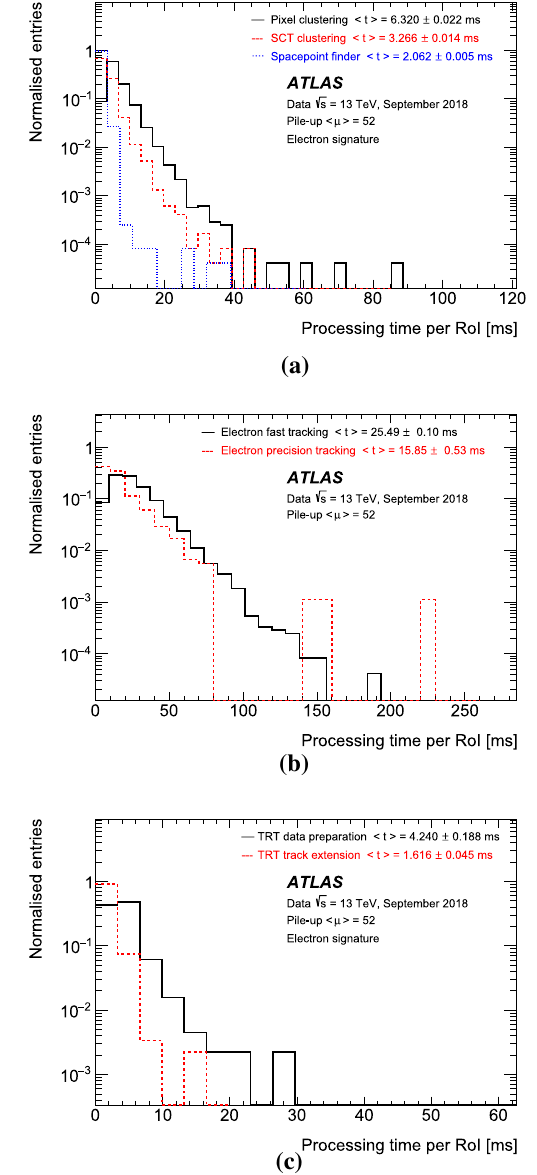
Fig. 11 The processing time for electron tracking related algorithms; a the data preparation times, b the tracking algorithm times, and c the TRT data